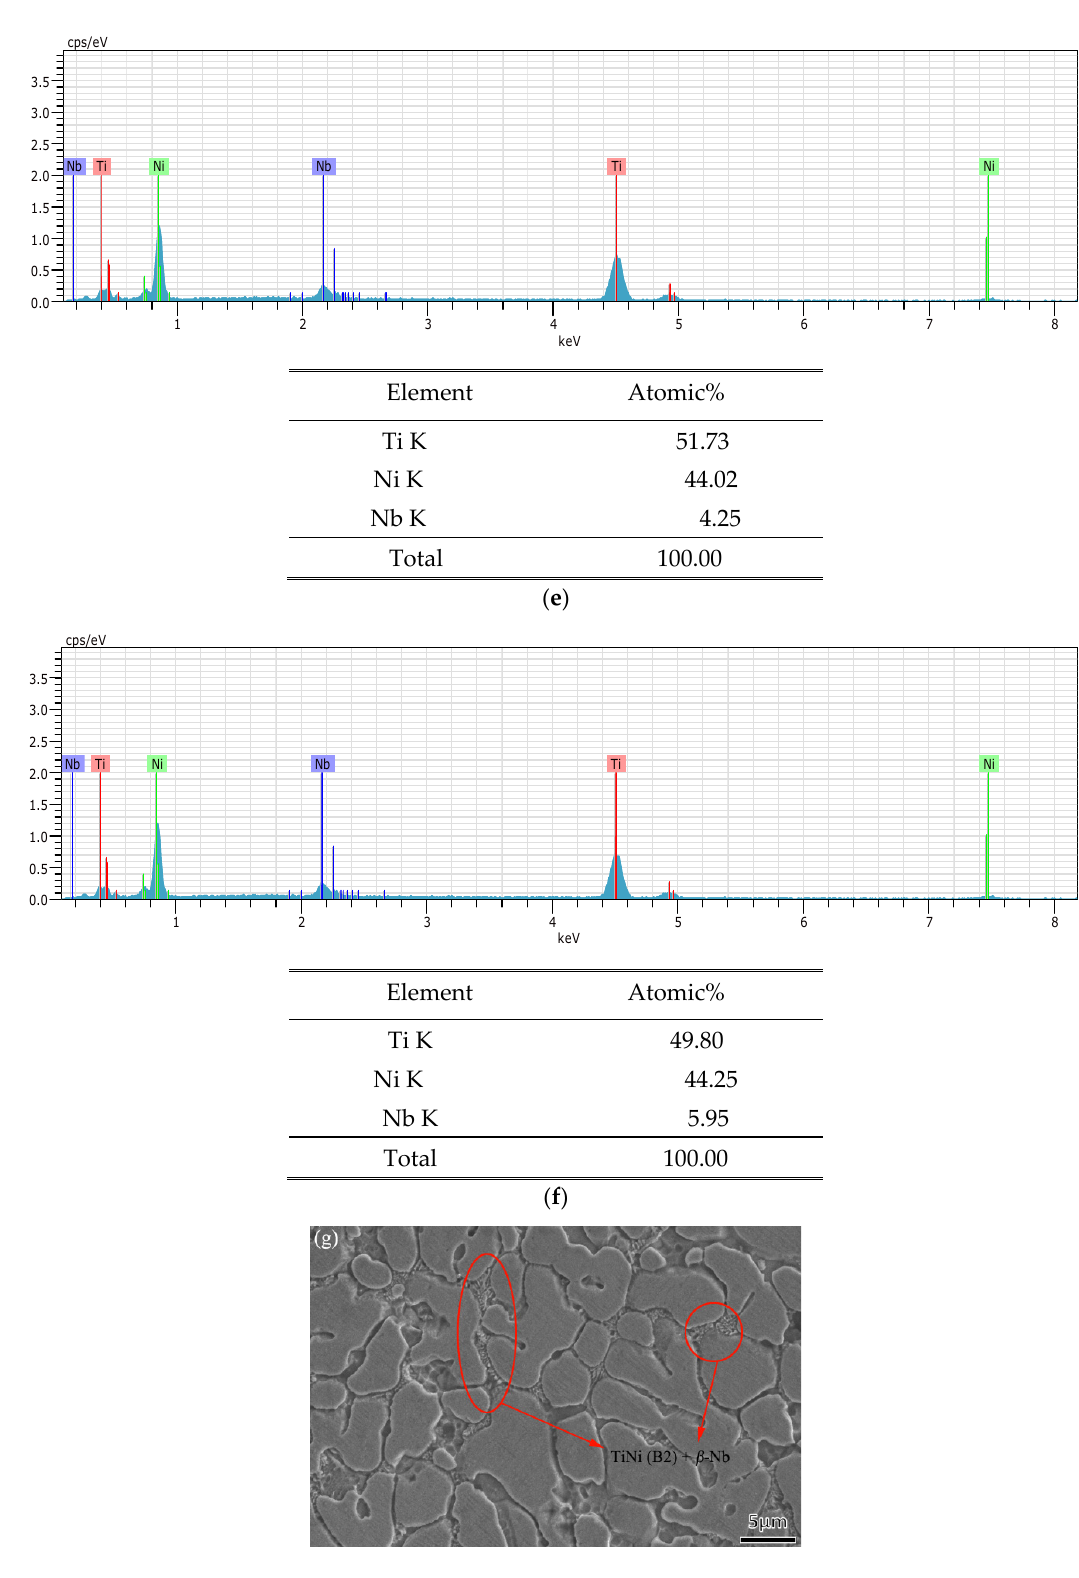
Figure 2. SEM surface morphologies of: ( a ) TiNi 44 Nb 2 , ( b ) TiNi 44 Nb 4 , and ( c ) TiNi 44 Nb 6 alloys. EDS analysis for ( d ) TiNi 44 Nb 2 , ( e ) TiNi 44 Nb 4 , and ( f ) TiNi 44 Nb 6 alloys, ( g ) the higher magnification view for ( c ).